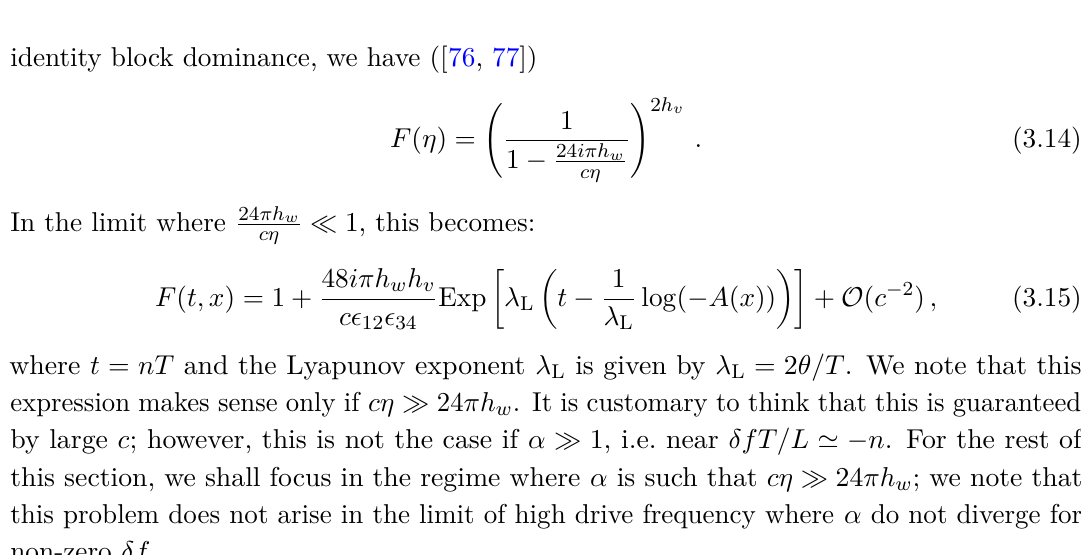
Figure 1 . Schematic representation of fixed points on the circle. The two red dots correspond to the two fixed points, while the blue dots label the position of the two operators. For non trivial behaviour, both the operators have to be on the same side of the fixed